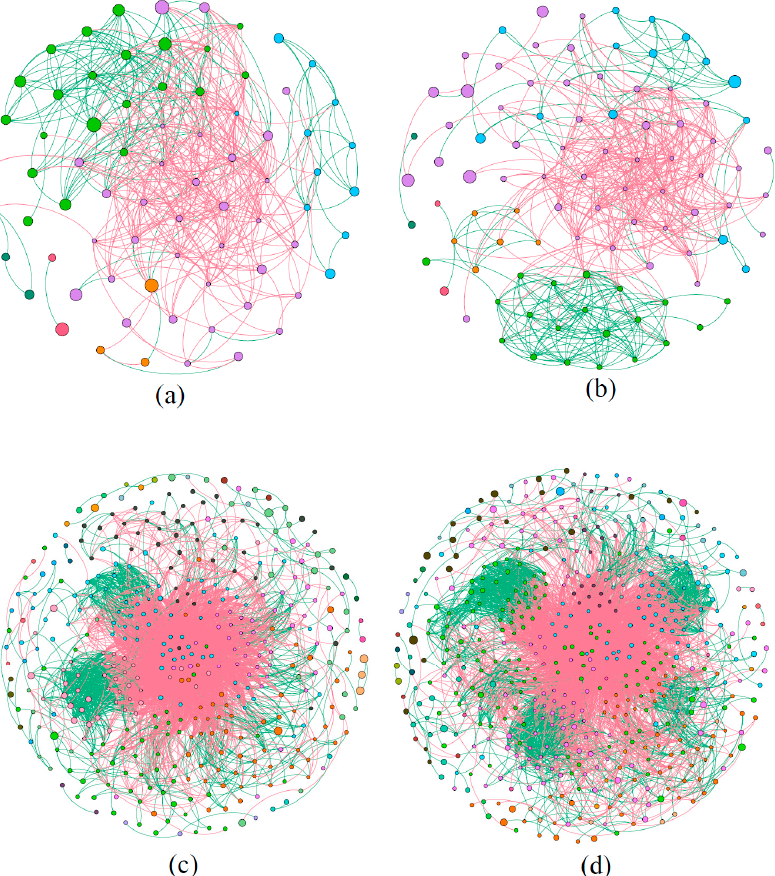
Figure 7. Molecular ecological network of microbial community: ( a ) phytoplankton of control pond, ( b ) phytoplankton of MC-treated pond, ( c ) bacteria of control pond, ( d ) bacteria of MC-treated pond. Each treatment was based on 12 water samples, used to construct an ecological network. Each node represents an OTU, the node size represents the relative abundance of OTUs. The number of nodes and links in the network is an indicator of the scale and complexity of the network. The more nodes and links, the higher the species richness and the complexity of species interaction. The red line indicates a negative correlation, and the green line indicates a positive correlation. The positive and negative correlations in the network can be used to infer the relationships between microorganisms. For example, a positive link represents a niche consistency or symbiotic relationship.